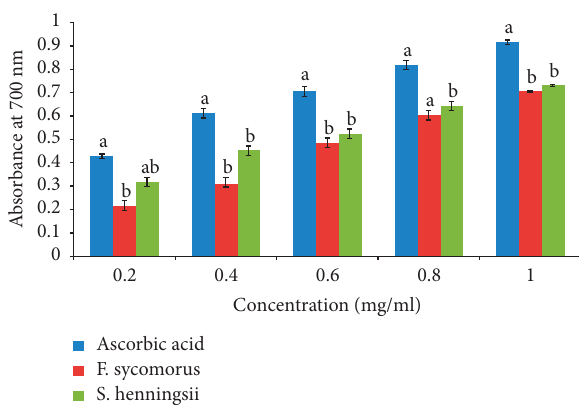
Figure 3: Analysis of ferric reducing power of S. hennningsii , F. sycomorus , and the standard ascorbic acid. Values are expressed as mean ± SEM of the three replicates. Column means followed by the same superscript letters were not signifcantly diferent ( p > 0 . 05) by one-way ANOVA followed by Tukey’s post hoc